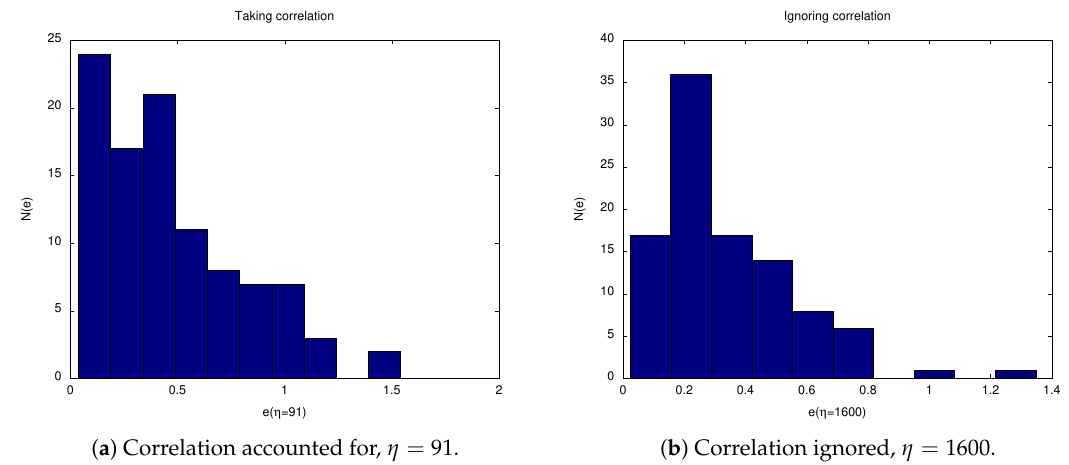
Figure 6. Histograms of the end-point error e from 100 observation sequences at the optimal value of η in both scenarios when error’s correlation is taken into account or